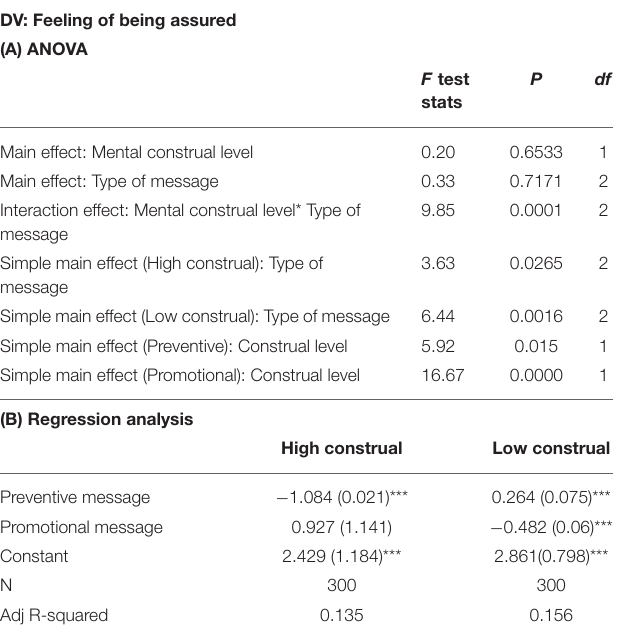
TABLE 4 | Testing for the effects of mental construal, technology type, and their interaction on response (Experiment 2: Change of pro-environment behavioral intentions).